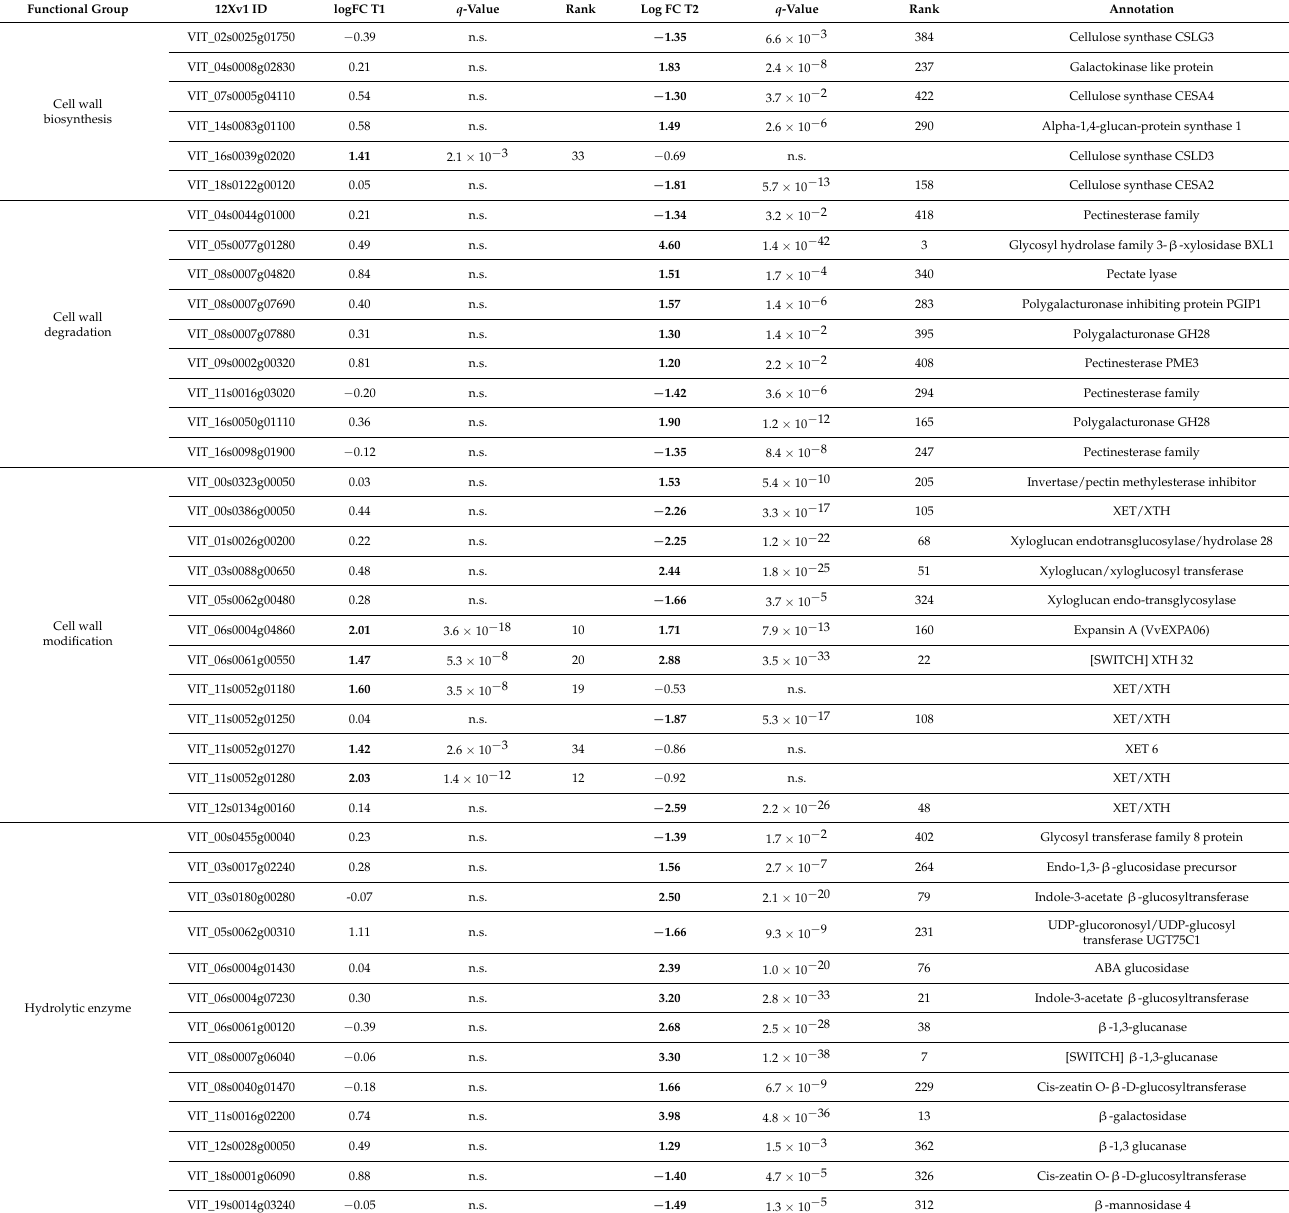
Table 1. List of selected genes differentially expressed related to the cell wall metabolism in the rachis of BS grape clusters at stage T1 (pre-symptomatic EL-34,35, 2011) and at stage T2 (symptomatic EL-36,37, 2011). Results are shown as log 2 FC and significance is based on an adjusted q -value of 0.05; significant results in bold letters. Further information is given in Table